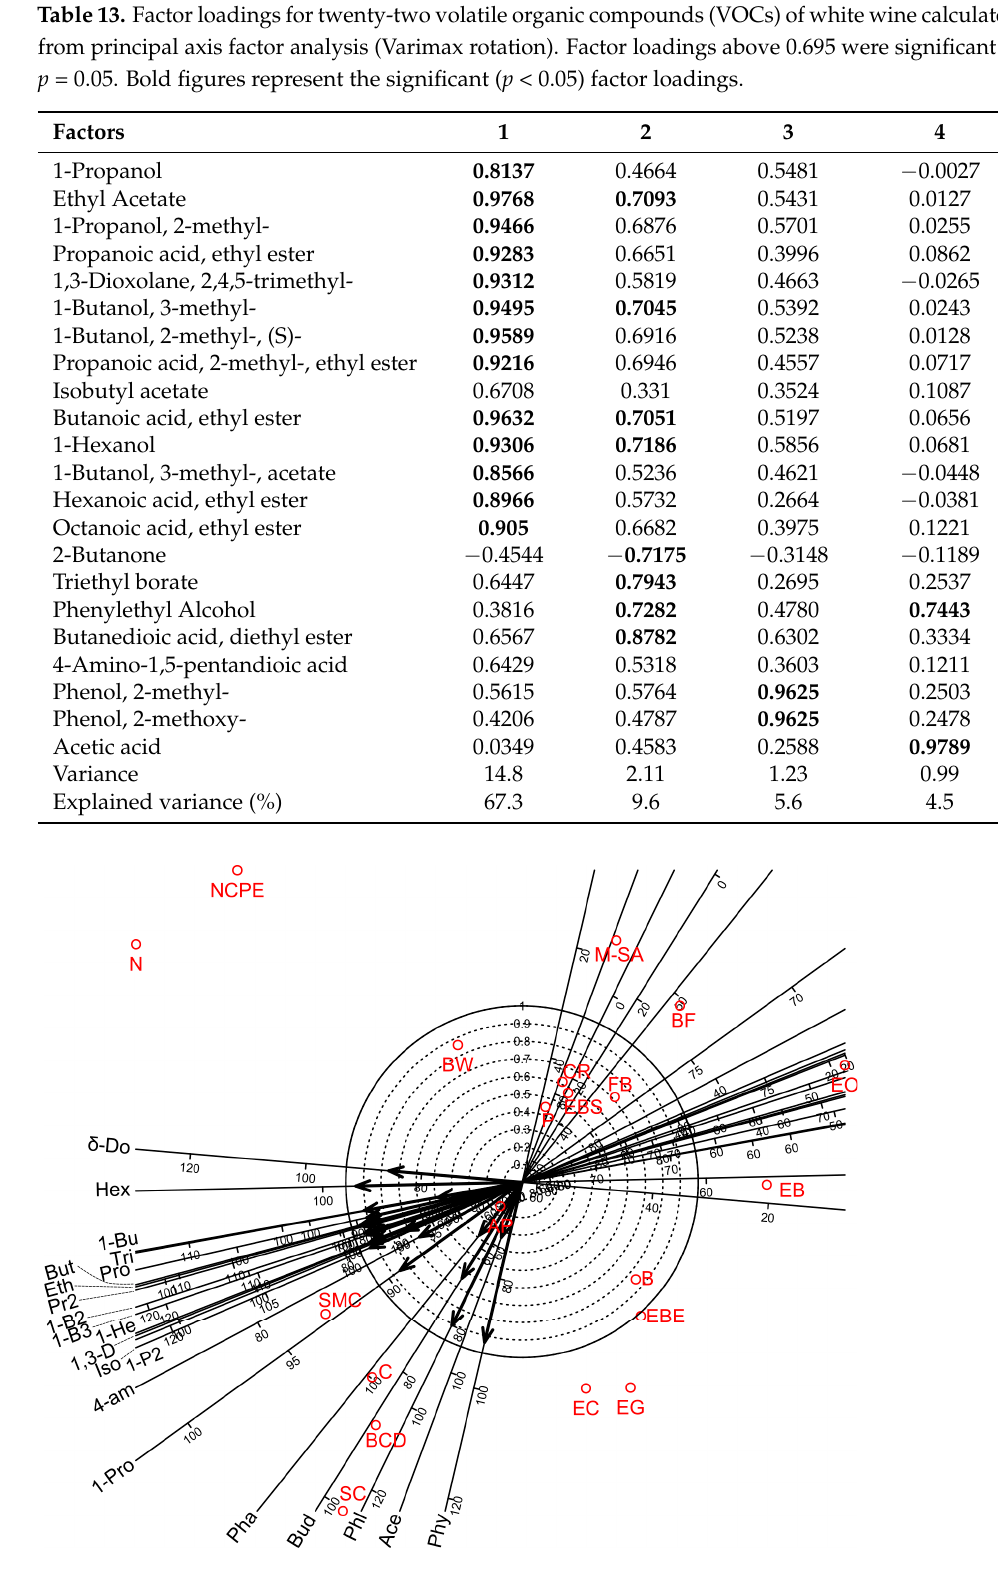
Table 14. Pearson correlation coefficients ( r ) amongst 10 organoleptic parameters of white wine from Debrecen-Pallag, Hungary. Bold figures represent the significant ( p < 0.05) correlation coeffi- cient values among parameter pairs. Colour